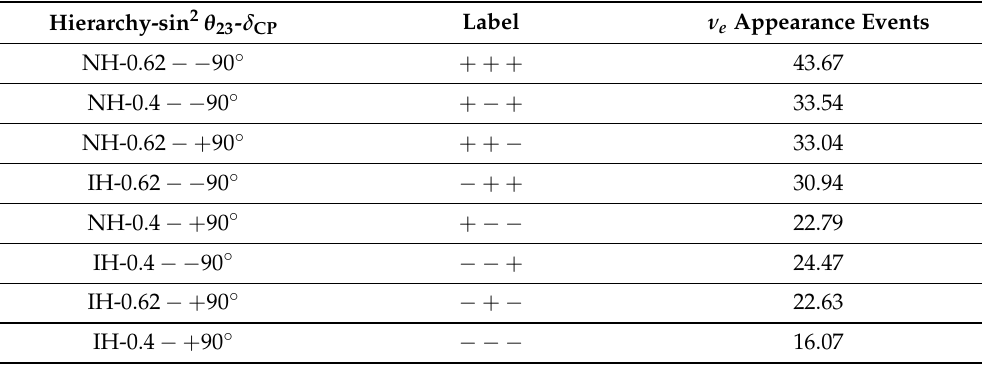
Table 4. Expected ν e appearance events of NO ν A for 6.05 × 10 20 POT, and for eight different combi- nations of unknown parameters.